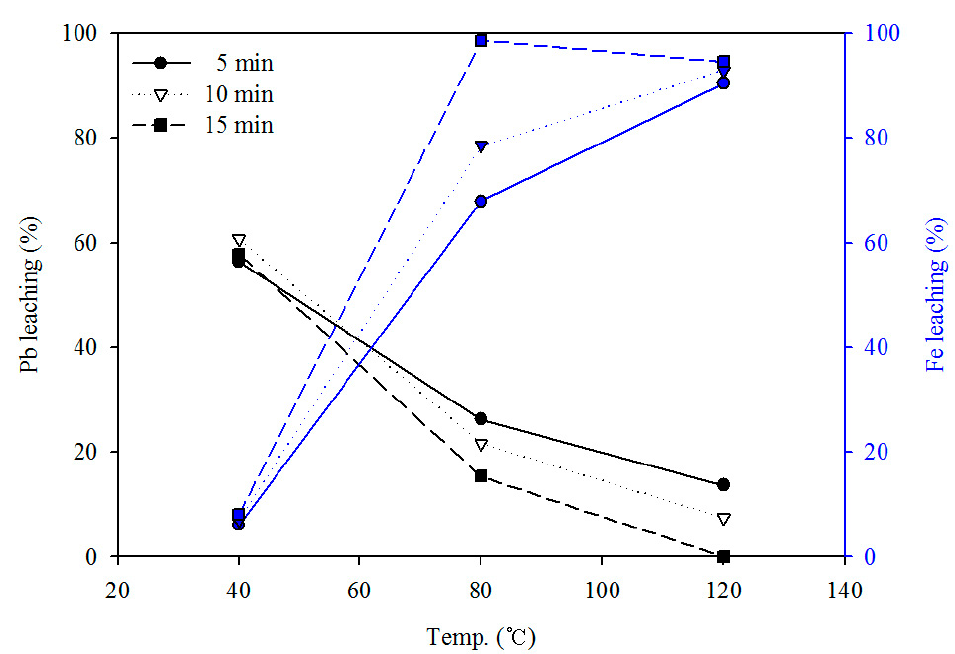
Figure 8. Effect of temperature on the leaching efficiencies of Pb and Fe from the refractory gold concentrate. The leaching conditions were an HNO 3 concentration of 1.0 M and a reaction temperature of 40, 80 and 120 °C.